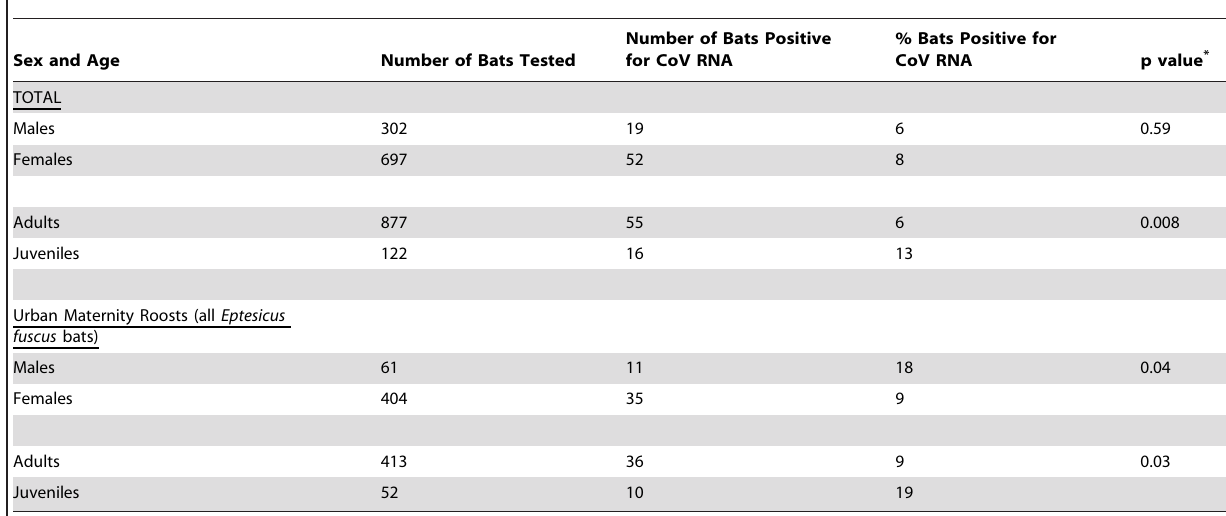
Table 4. Percent of bats positive for coronavirus RNA in fecal and/or anal swab samples by age and sex (N =999).